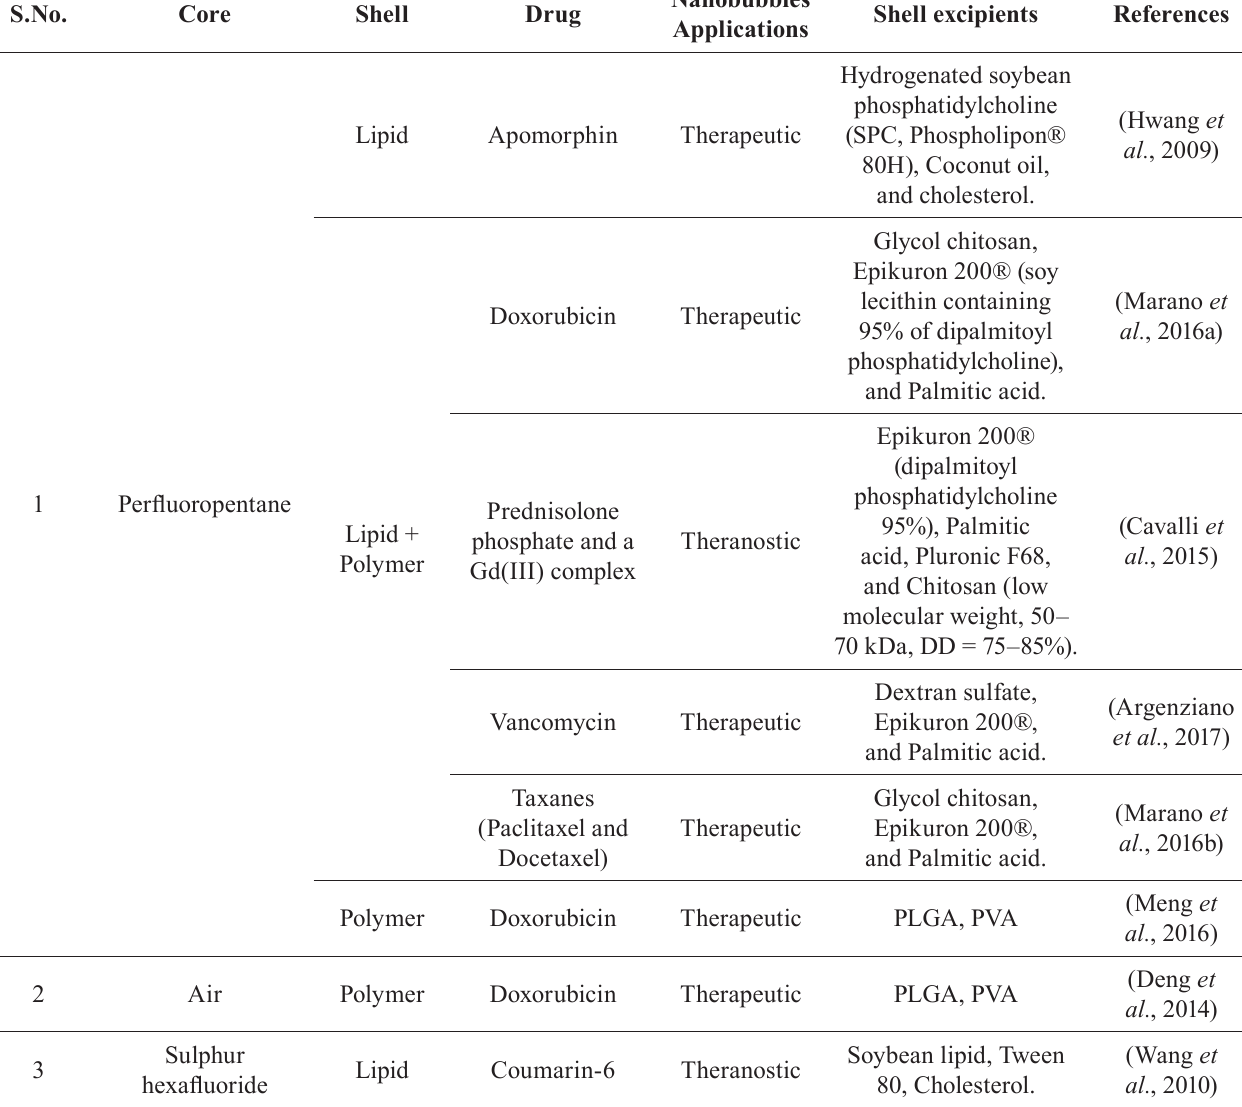
TABLE II - Various nanobubble used for drug delivery